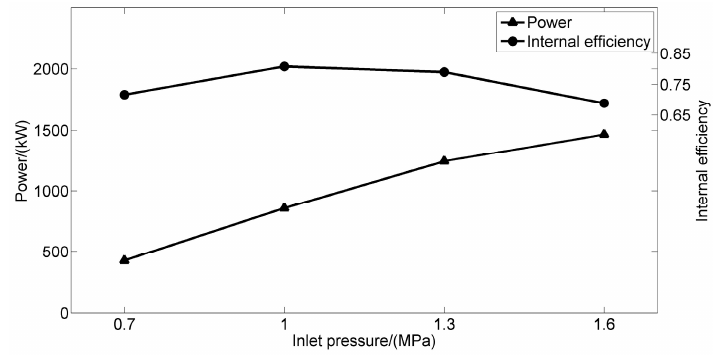
Figure 14. Internal efficiency and power for different inlet pressure ( P o = 0.19 Mpa, n = 2400 rpm).